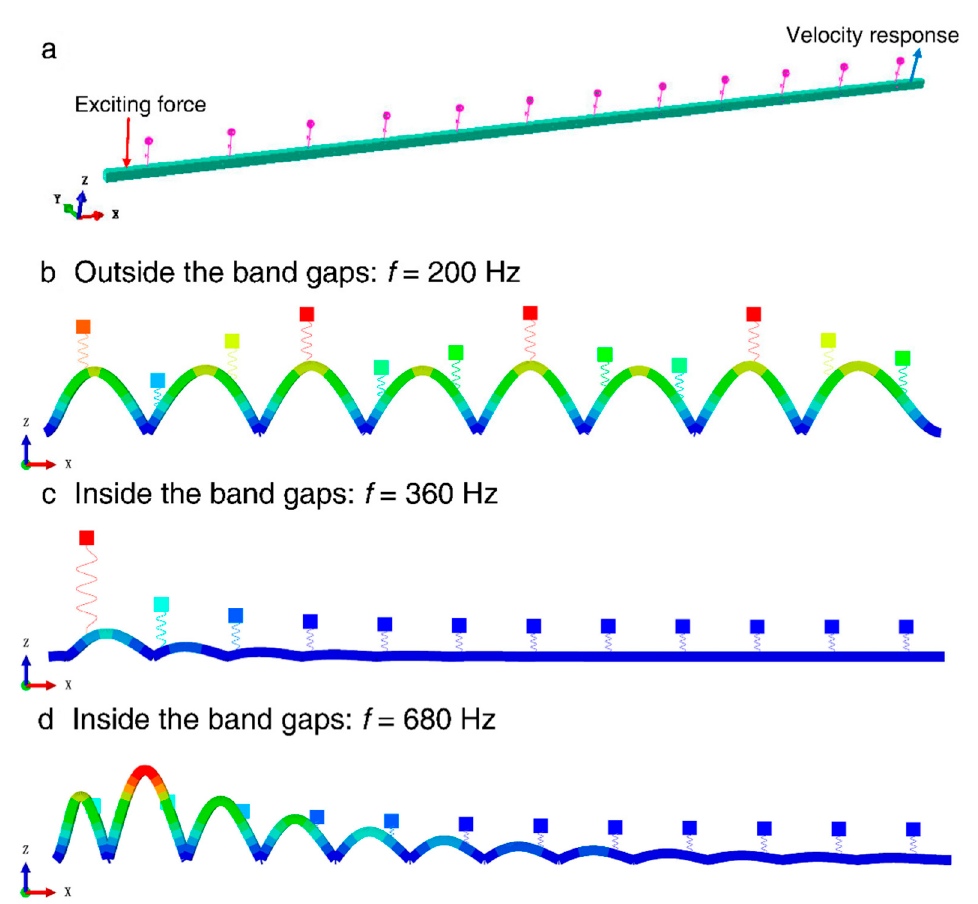
Figure 3. ( a ) Finite element model of the finite long periodic oscillator coupled damping beam with 12 unit cells; ( b – d ) the flexural wave vibration propagation characteristics at specific frequencies. Materials 2020 , 13 , x FOR PEER REVIEW